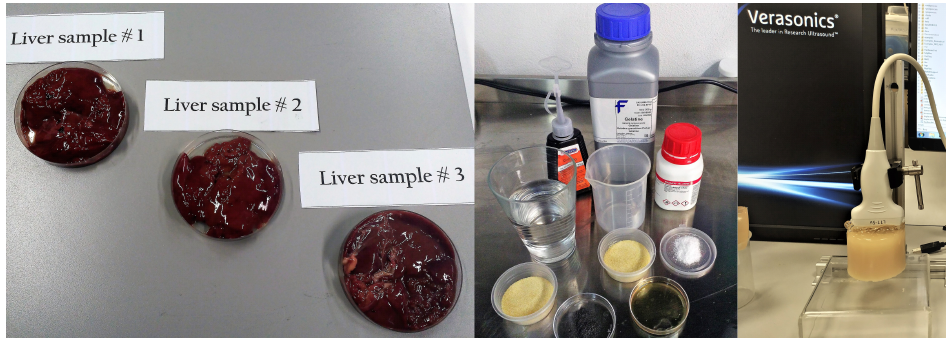
Figure 2. Three ex vivo liver samples, phantom ingredients, and one of the phantoms subjected to shear wave elastography imaging.